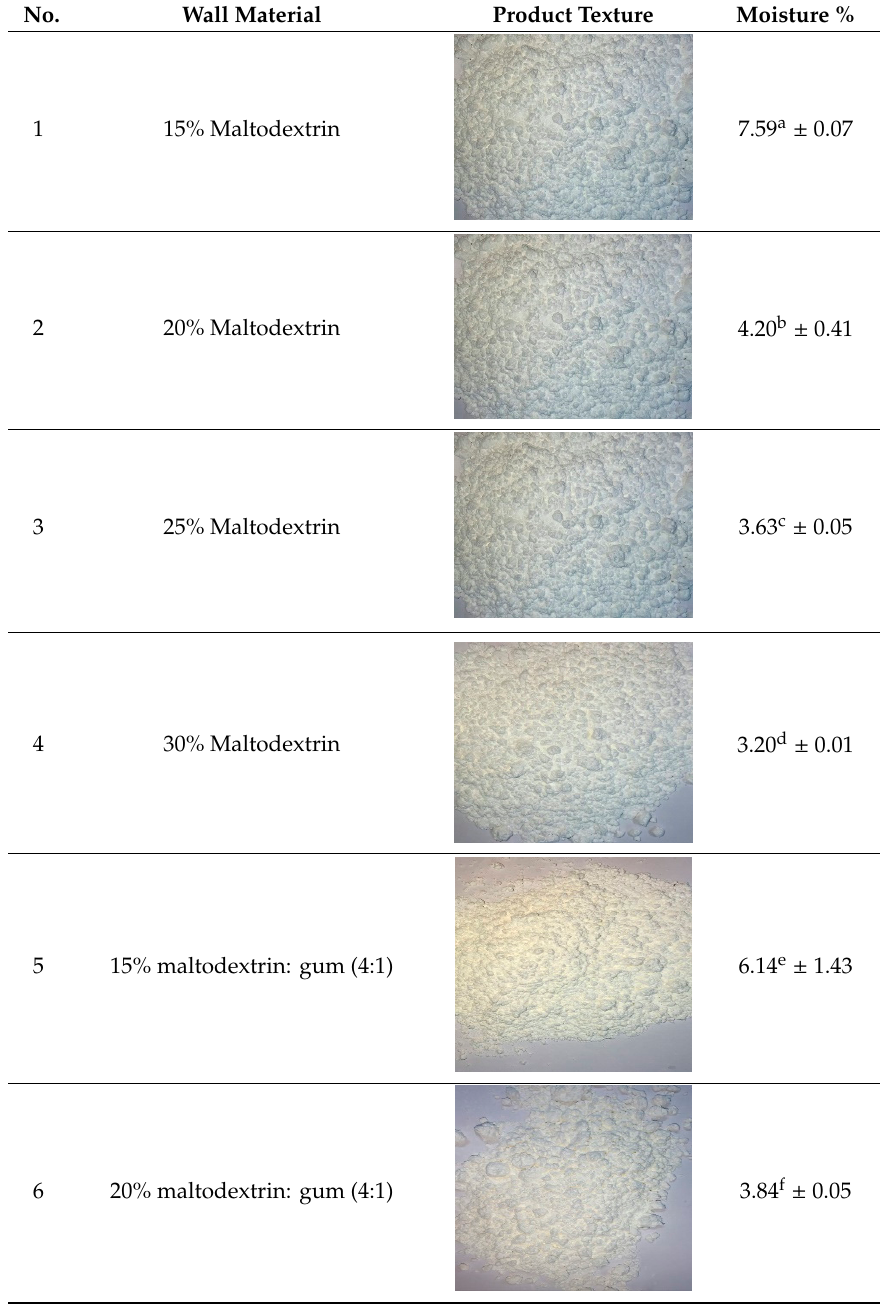
Table 3. Moisture content and texture of microencapsulation powder produced at different concentrations of the wall material.